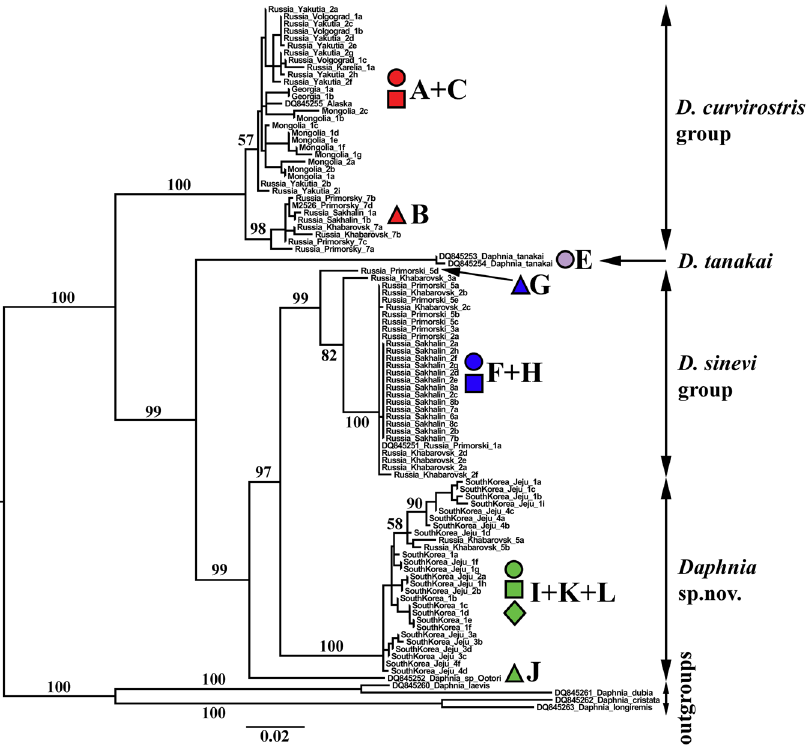
Figure 3. Maximum likehood tree based on sequences of nuclear HSP90 gene representing the diversity among clades of Daphnia curvirostris group. The support values of individual nodes are based on maximum likelihood. Colors and shapes correspond to mitochondrial phylogroups in Figs 1 and 2.